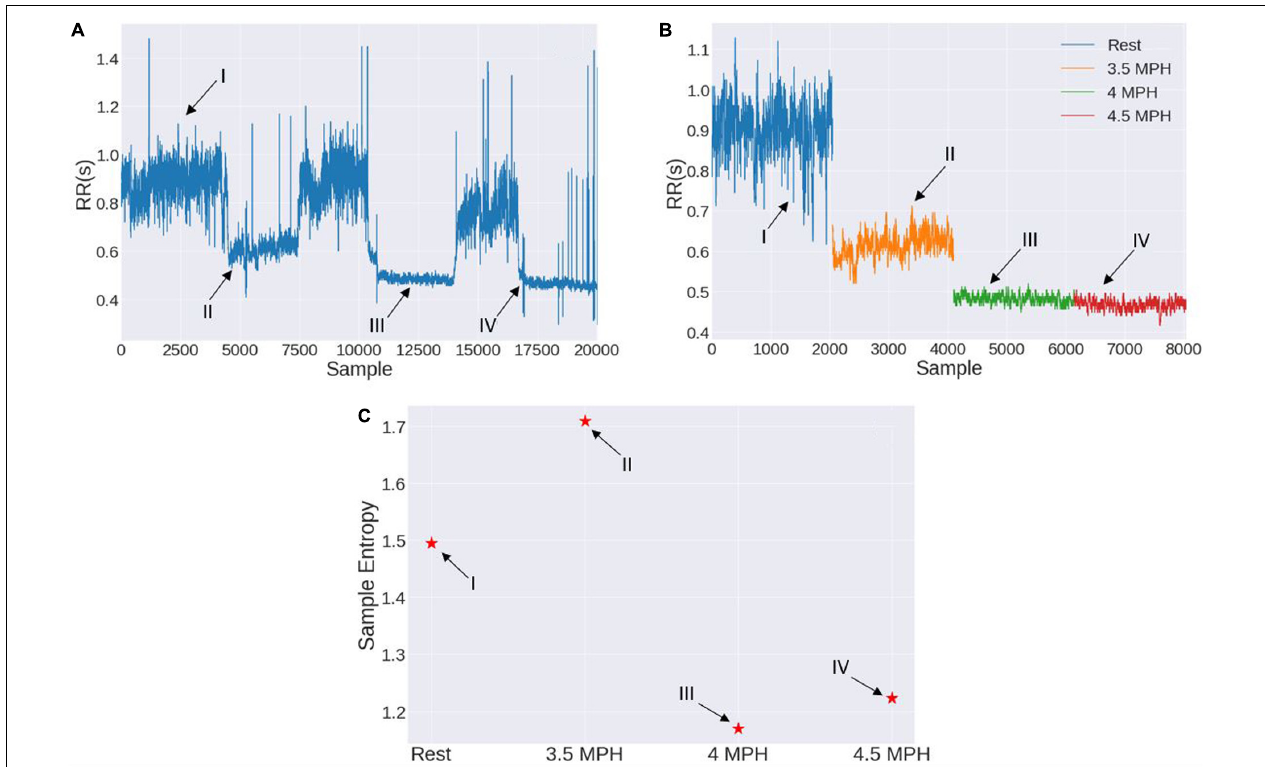
FIGURE 9 | This figure shows a stress test performed by an active person. (A) Original time series, (B) the stages of the stress test, and (C) sample entropy for the time subseries of each stage. The different stages of the test are: (I) 1 h at rest, (II) walked half an hour at a speed of 3.5 mph, (III) walked at 4.0 mph preceded by a half-hour break, (IV) walked at 4.5 mph, also preceded by a half-hour break. In this figure we can see what has already been discussed in the article, an active person has an entropy-value at rest (I) . When walking at moderate speed the value of entropy tends to increase or maintain (II) , which is exactly the opposite of what happens with sedentary people. It is necessary to increase the walking speed so that the decrease in entropy is noticed (III,IV) .